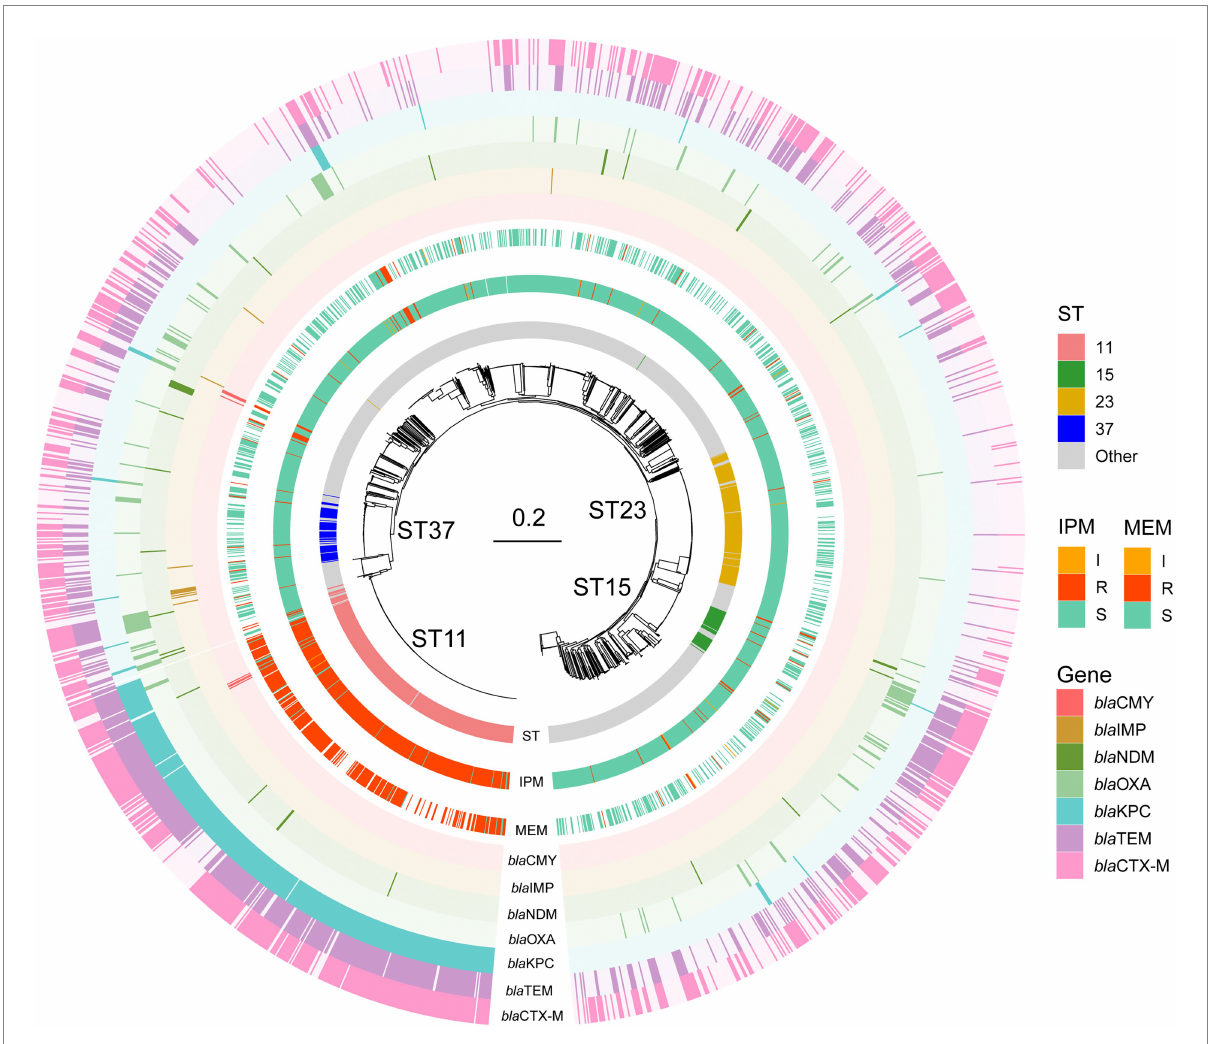
FIGURE 1 Phylogenetic tree, sequence type, and phenotype of the KP isolates for the two carbapenems. STs are shown in the inner ring and the most common STs ST11, ST23, ST37, and ST15 were marked. IPM and MEM phenotypes are in the middle ring. IPM: imipenem, MEM: meropenem. I, R, and S represent intermediate, resistant, and susceptible, respectively. In the outer ring, seven bla genes are labeled by different colors. Bla genes: beta-lactam resistance